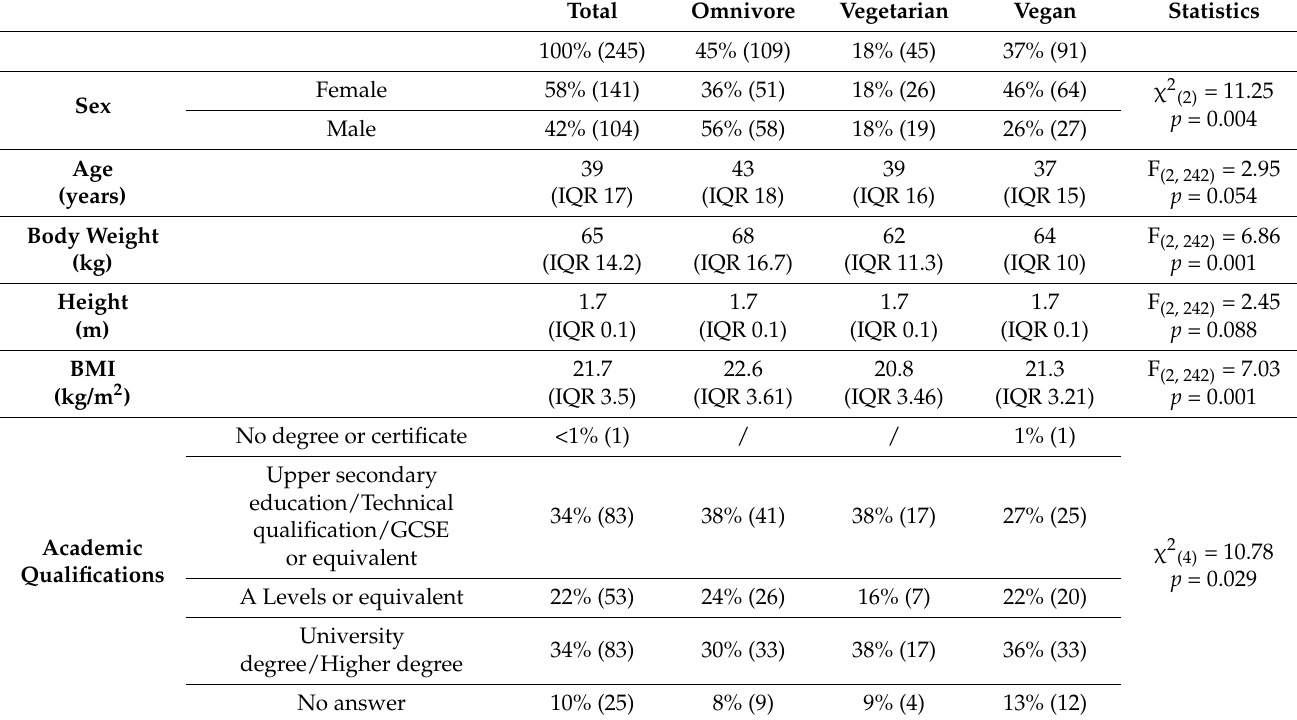
Table 1. Traits, Sociodemographics, and Motives of Runners Displayed by Dietary